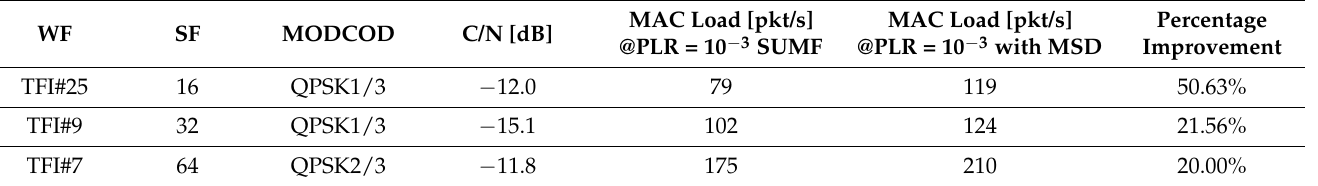
Table 2. Examples of throughput gain.